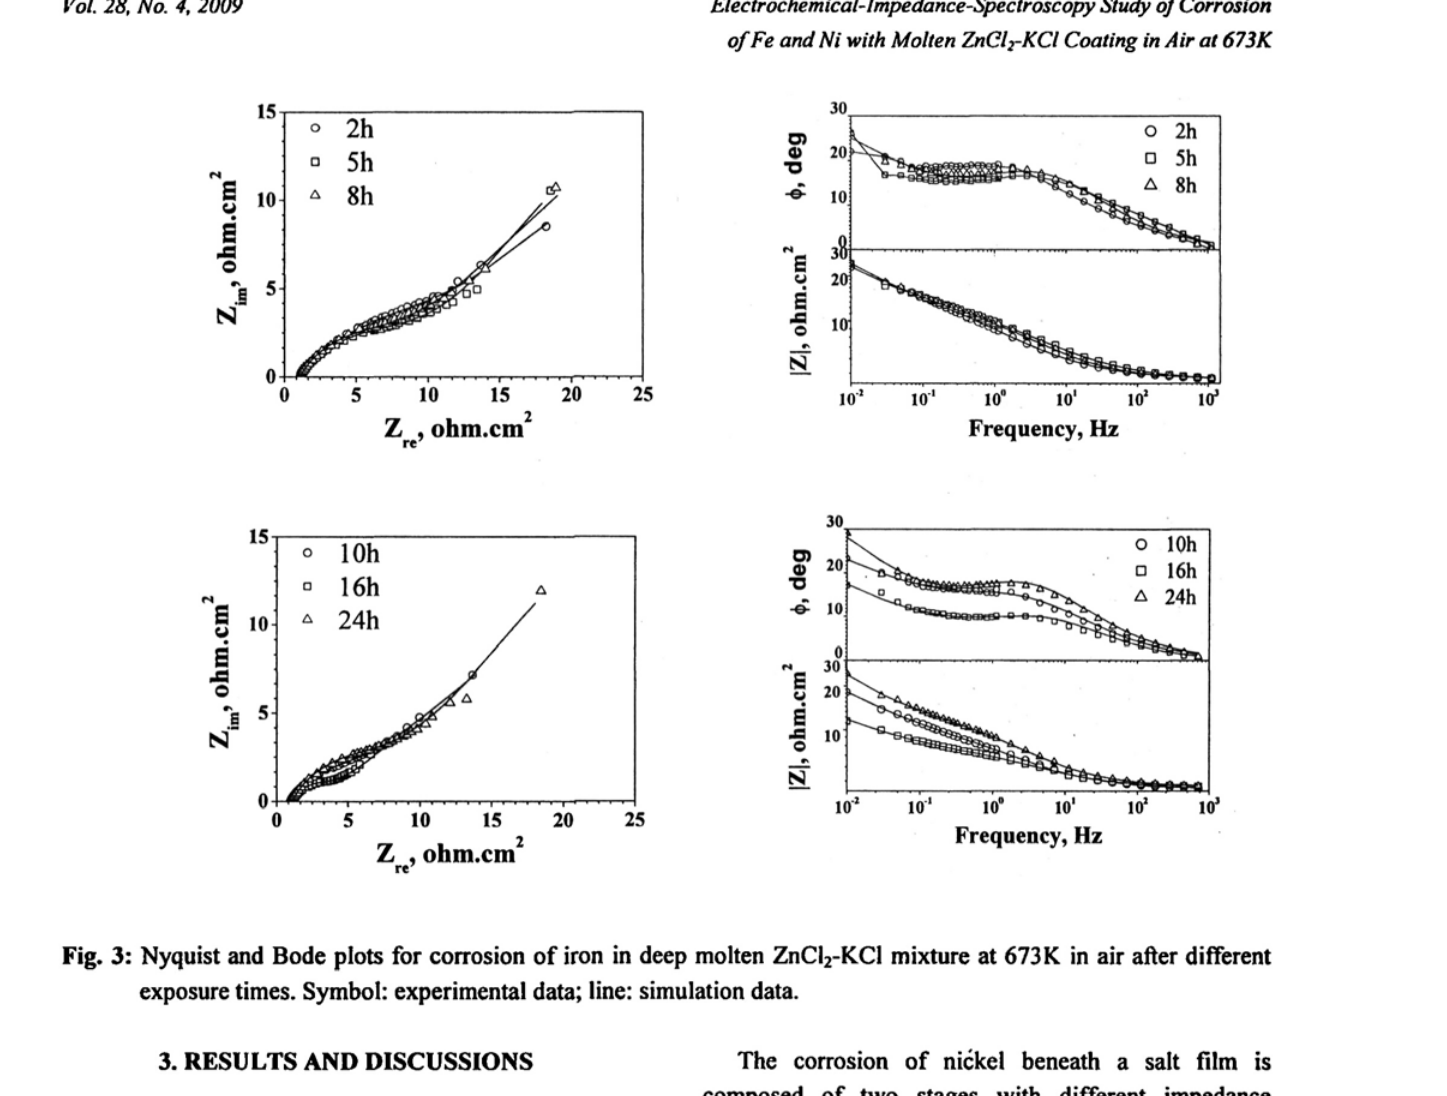
Fig. 3: Nyquist and Bode plots for corrosion of iron in deep molten ZnCI exposure times. Symbol: experimental data; line: simulation